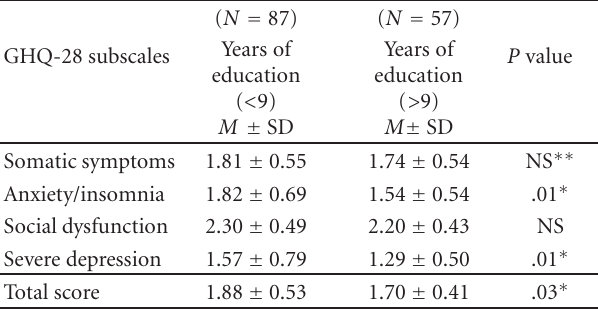
Table 4: Mean scores ± SD of GHQ-28 health subscales. Inde- pendent samples t -test demonstrating di ff erences between the two categories of